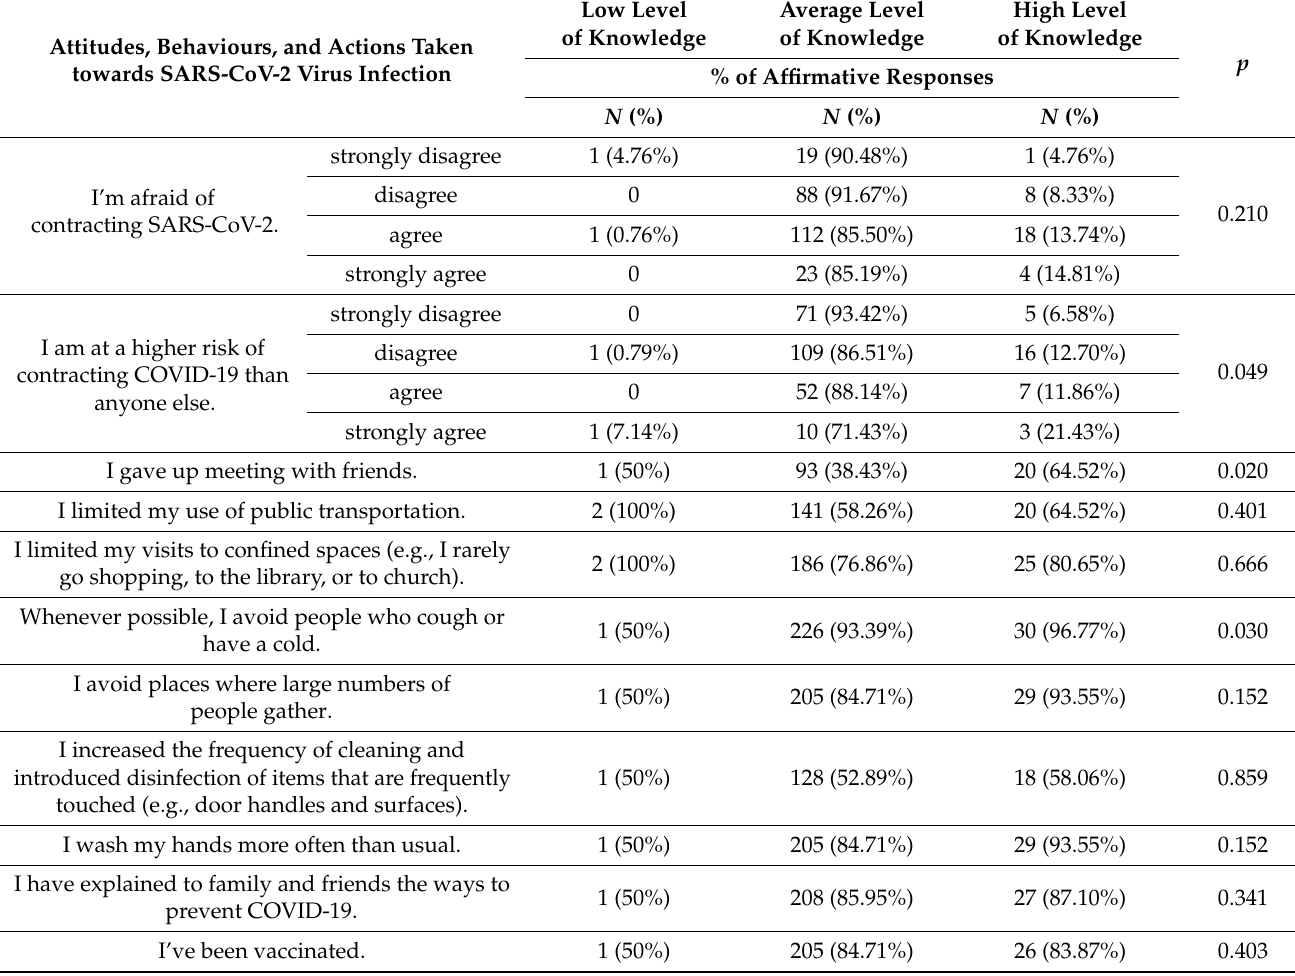
Table 5. Attitudes, behaviours, and actions taken towards SARS-CoV-2 infection by nursing, midwifery, and emergency medical services students and their level of knowledge. Attitudes, Behaviours, and Actions Taken towards SARS-CoV-2 Virus Infection